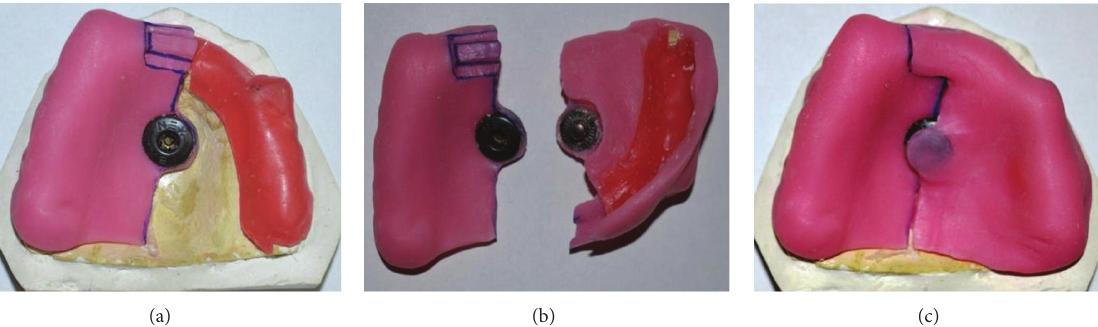
Figure 3: Fabrication technique for the sectional tray—Design 2.